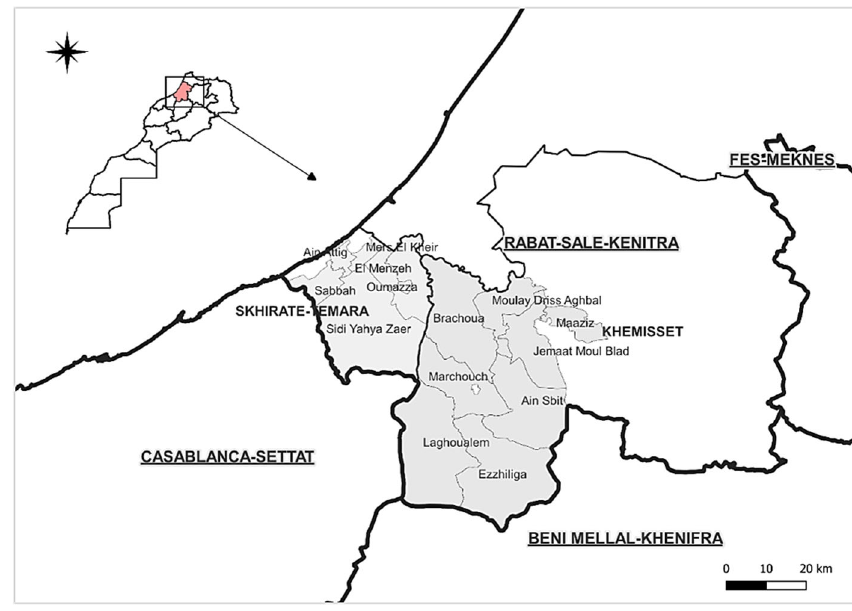
Figure 1. Map of surveyed counties (indicated by grey shades).